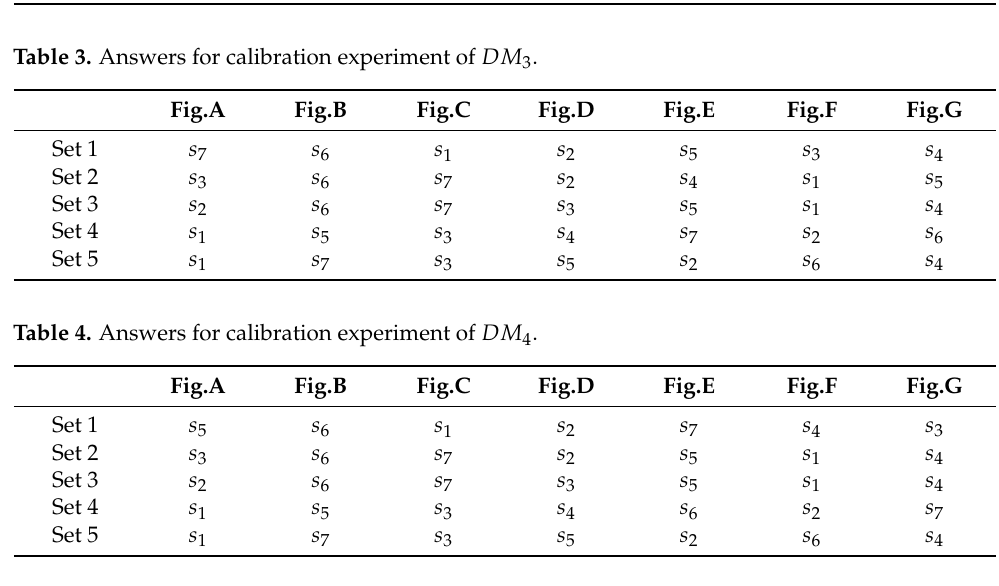
Table 5. Answers for calibration experiment of DM 5 .